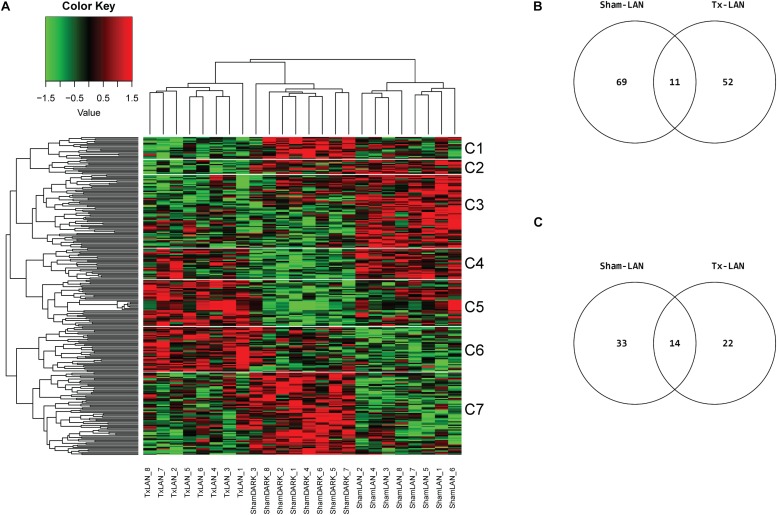
Microarray analysis of LAN exposure with and without hepatic denervation. (A) Heatmap of top 100 DEGs of 3 comparisons (Sham-DARK vs. Sham-LAN, Sham-LAN vs. Tx-LAN, Sham-DARK vs. Tx-LAN), presents expression profile of 244 unique genes. Individual subjects (animals) are presented by columns. Data are clustered on genes and samples. White lines and C-numbers on the right indicate clustered groups of genes responsible for the differences between biological groups. (B) Venn representing the number of affected DEGs (p < 0.001) when comparing Sham-LAN with Sham-DARK and Tx-LAN with Sham-DARK. Eleven DEGs were affected by both Sham-LAN and Tx-LAN when compared to Sham-DARK. (C) Venn diagram representing the number of pathways significantly (p < 0.05) enriched with top 5% of genes, based on p-value (FDR corrected), after exposure to LAN in Sham-animals compared to Sham-DARK animals and Tx-animals compared to Sham-DARK animals.